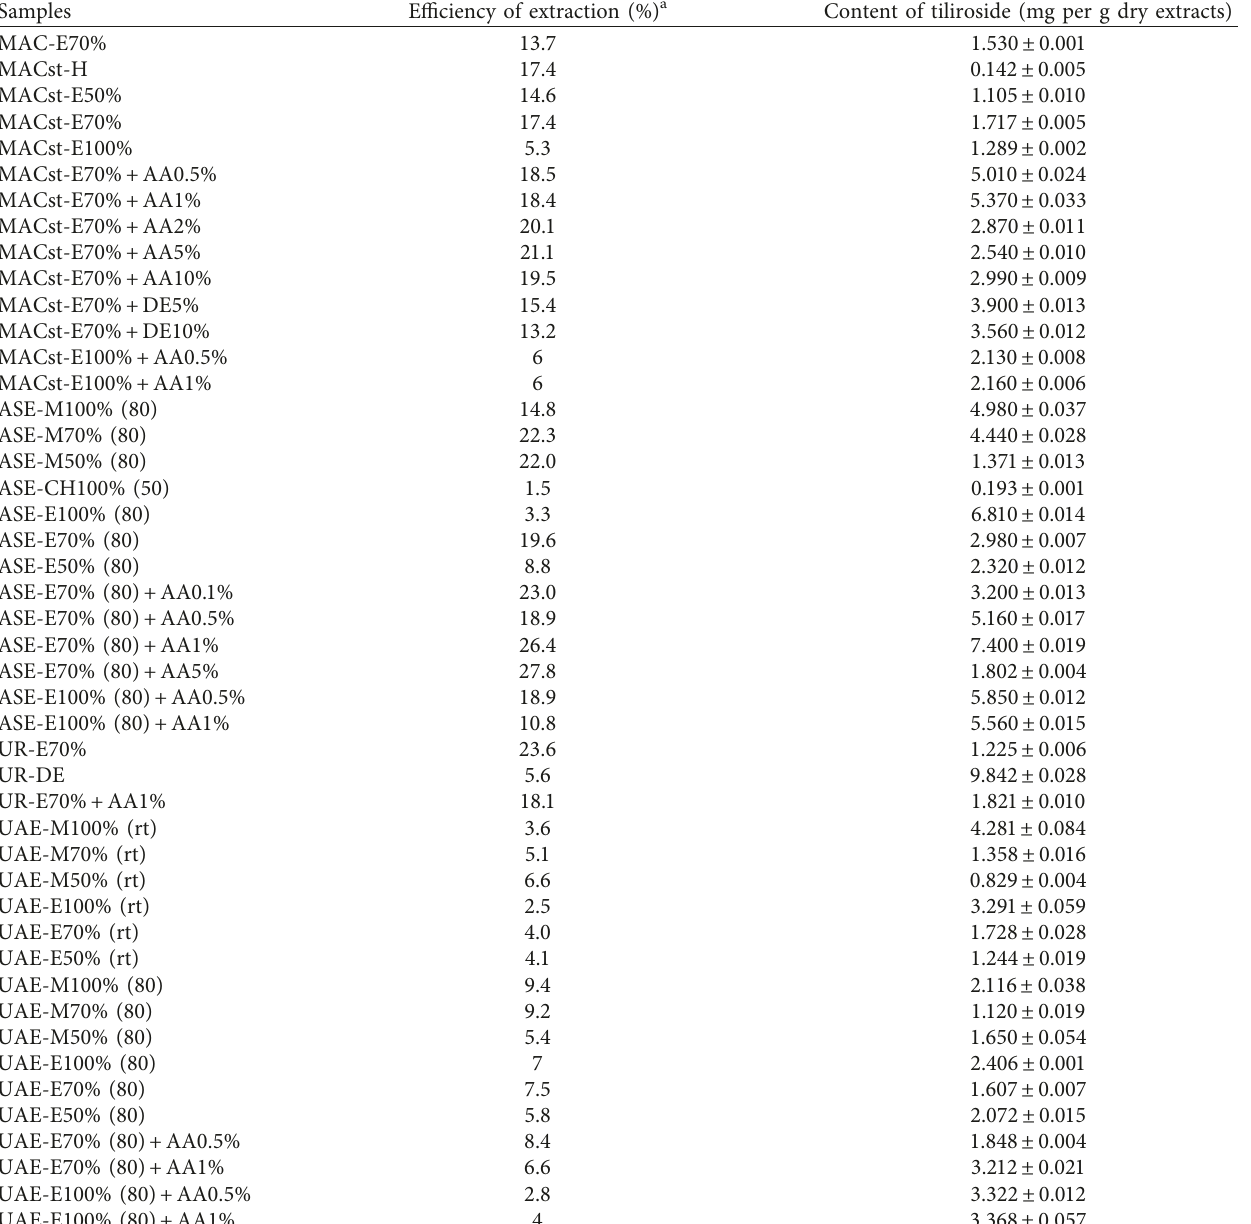
Table 7: Tiliroside contents in extracts from Tilia L ( ± SD, n �